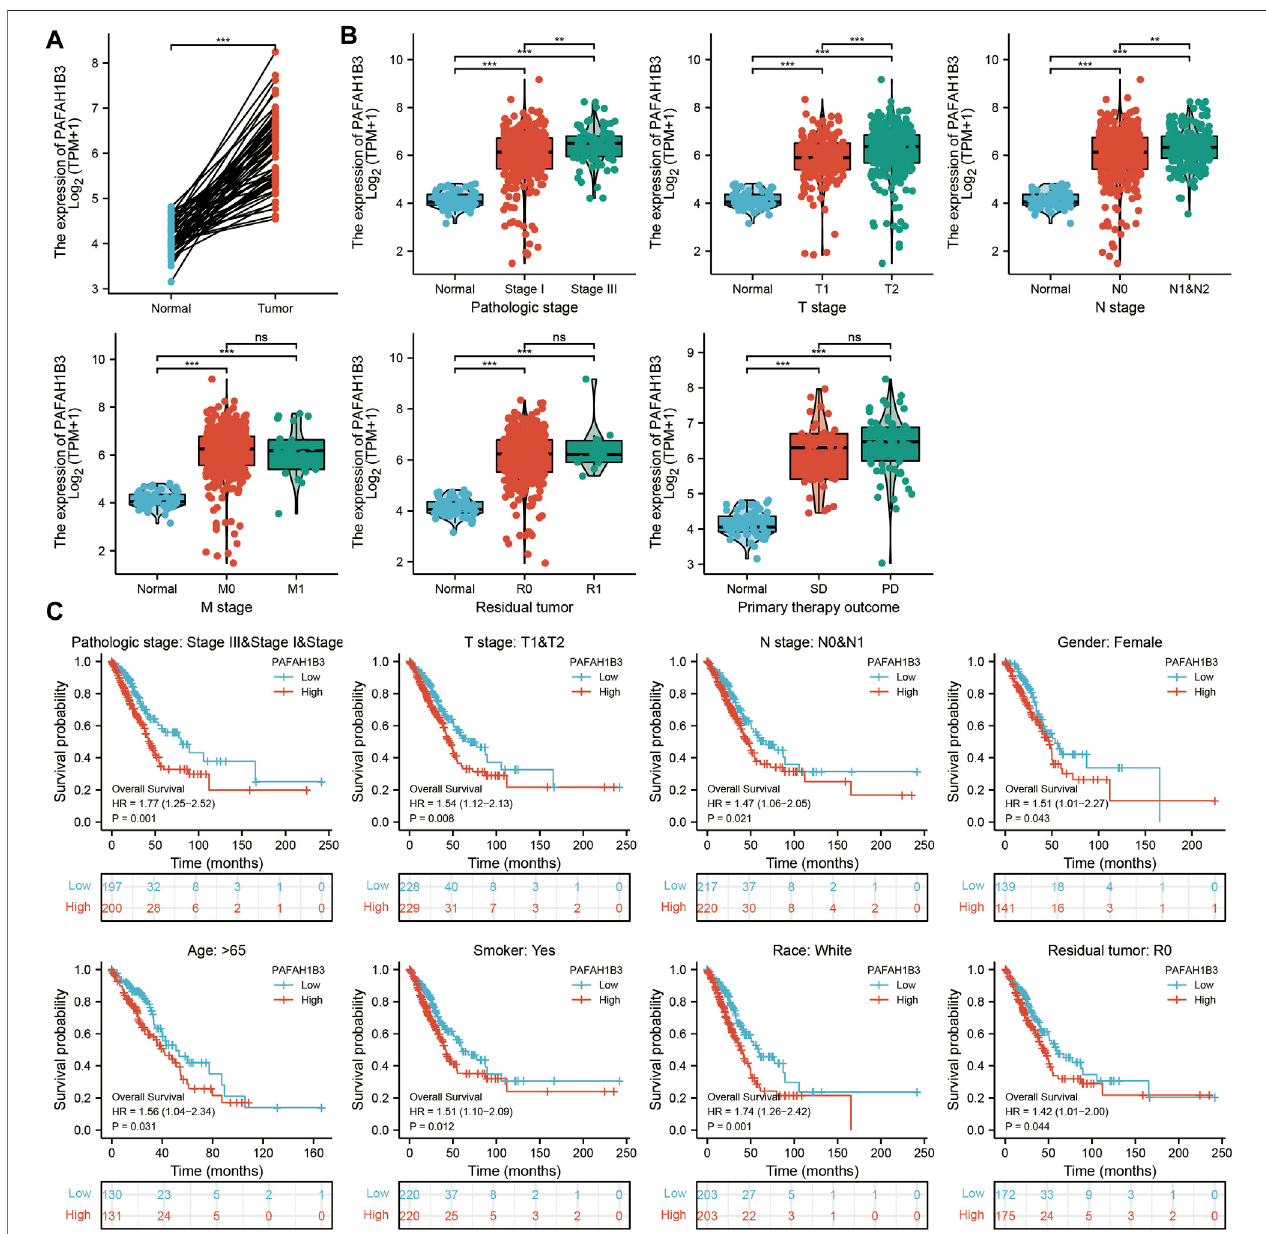
FIGURE 6 | PAFAH1B3 Is Correlated With Clinical Characteristics and Prognosis in NSCLC. (A) The expression of PAFAH1B3 in NSCLC. (B) The correlation between PAFAH1B3 expression and Clinical Characteristics in NSCLC, including the pathologic stage, TNM stage, residual tumor, and primary therapy outcome. (C) The prognosis of PAFAH1B3 in